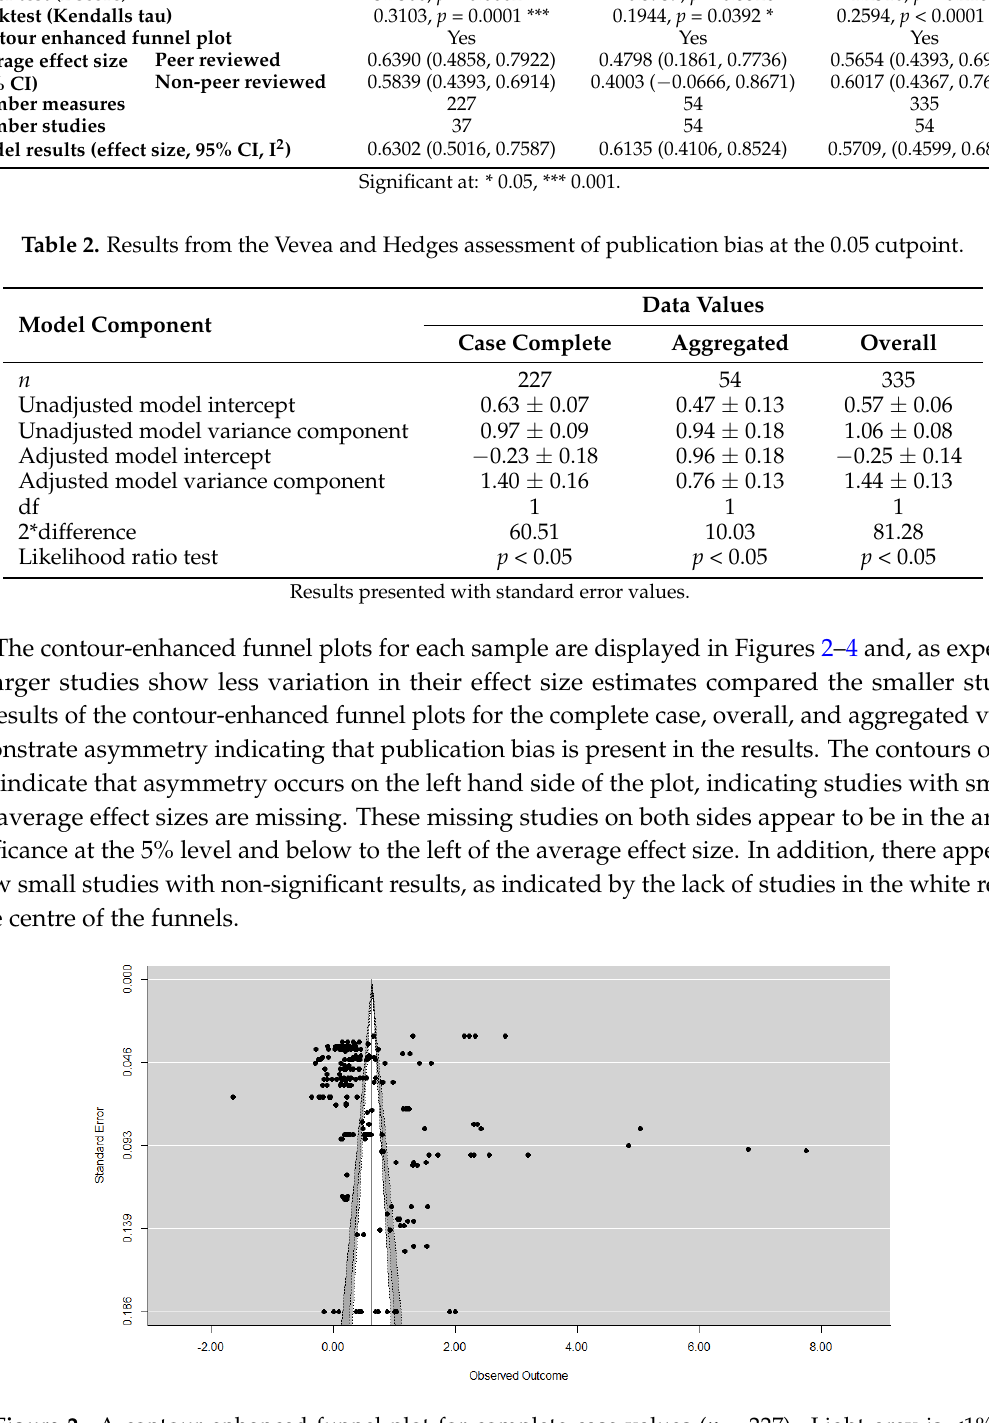
Table 1. Results from five assessments of publication bias.